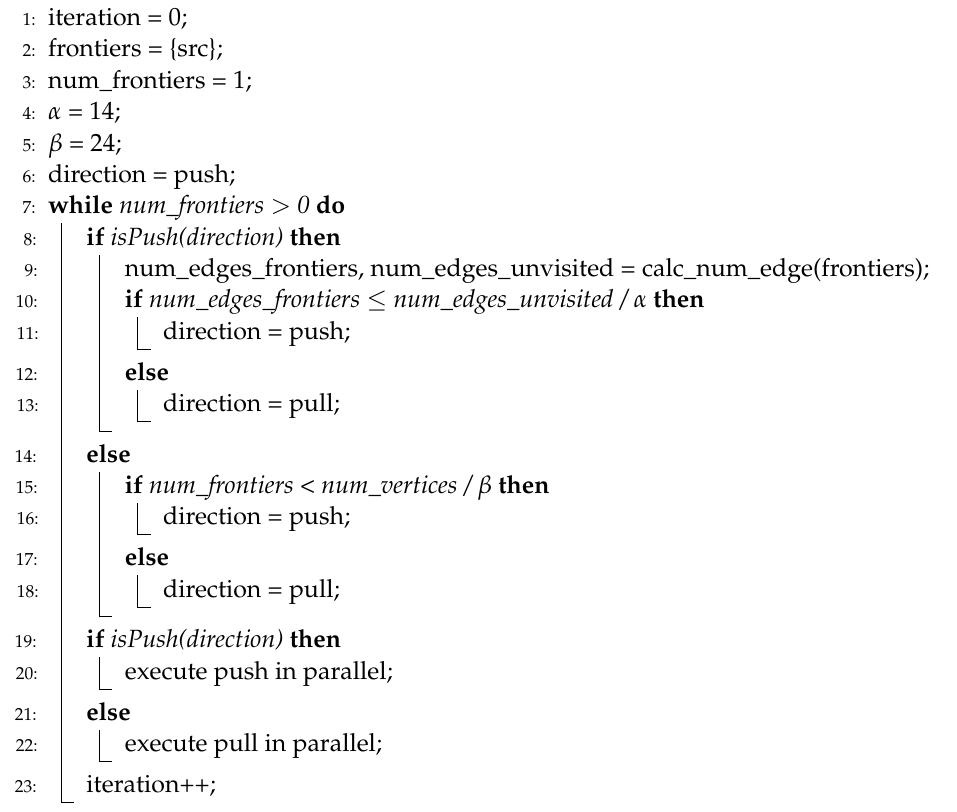
Algorithm 4 Direction-optimizing BFS in